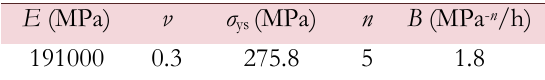
Table 1: Mechanical properties.